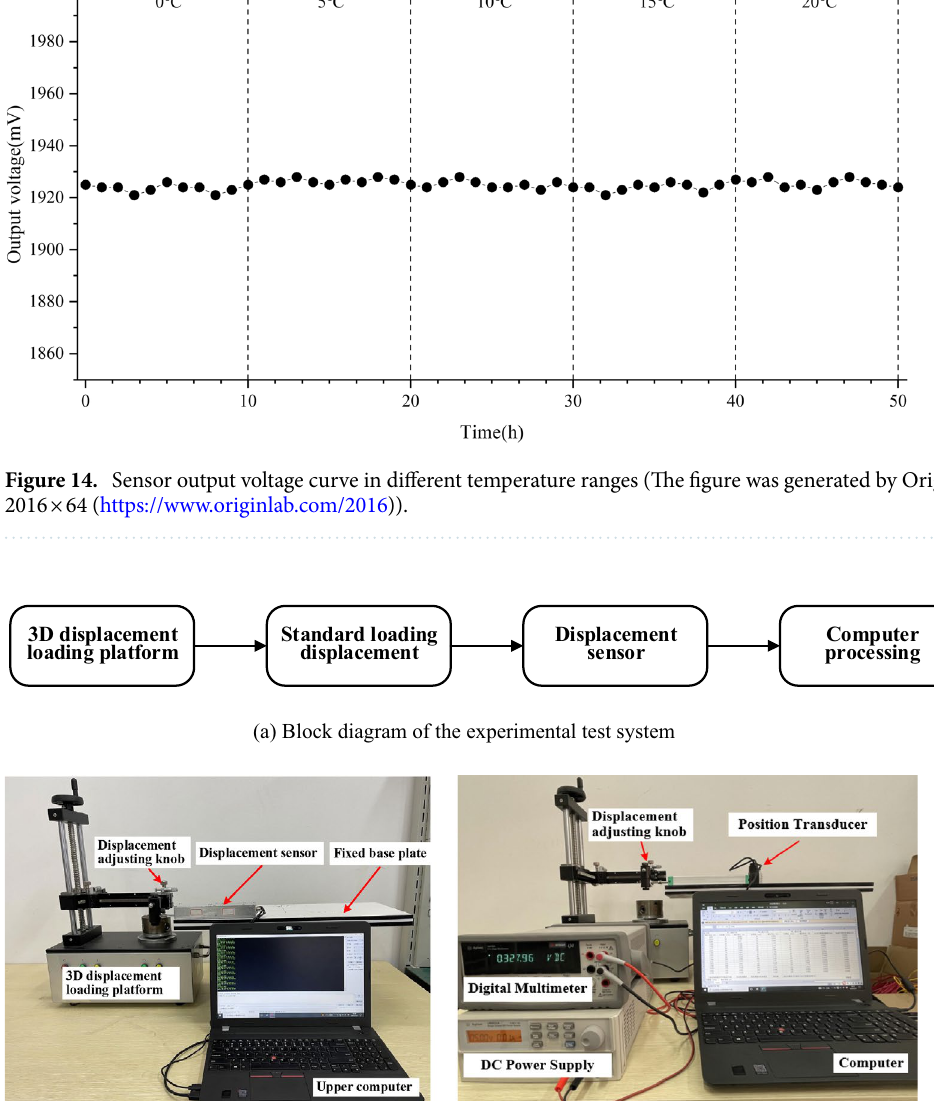
Figure 15. Static calibration system of the displacement sensor (( a , b , c )were generated by Microsoft Visio Professional 2016 (https:// www. micro soft. com/ zh- CN/ downl oad/ detai ls. aspx? id=